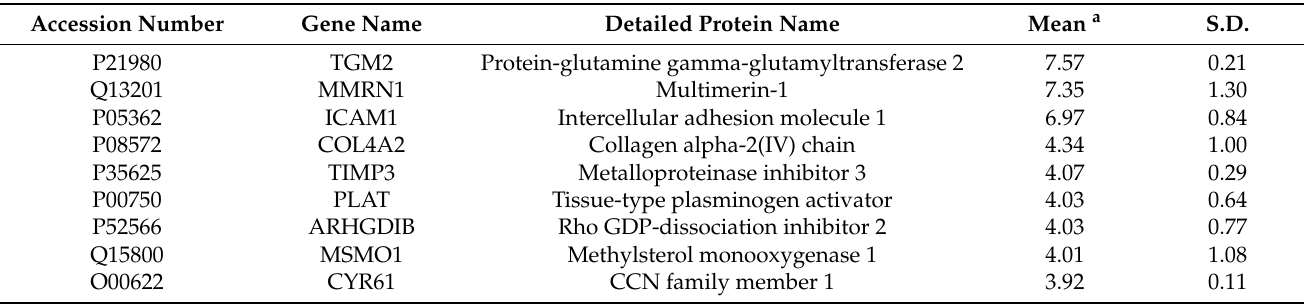
Figure 5. Improvement of cholesterol, fatty acids and sterols metabolism, and mitochondrial functions in hBP-coc. ( A ) Top-level gene ontology analysis and ( B ) Interaction map of the 90 proteins quantified in hBP-coc. *: Top-20 proteins. Table 2. Top 20 of the 90 proteins enriched in cocultured hBP. The complete list is available in Table